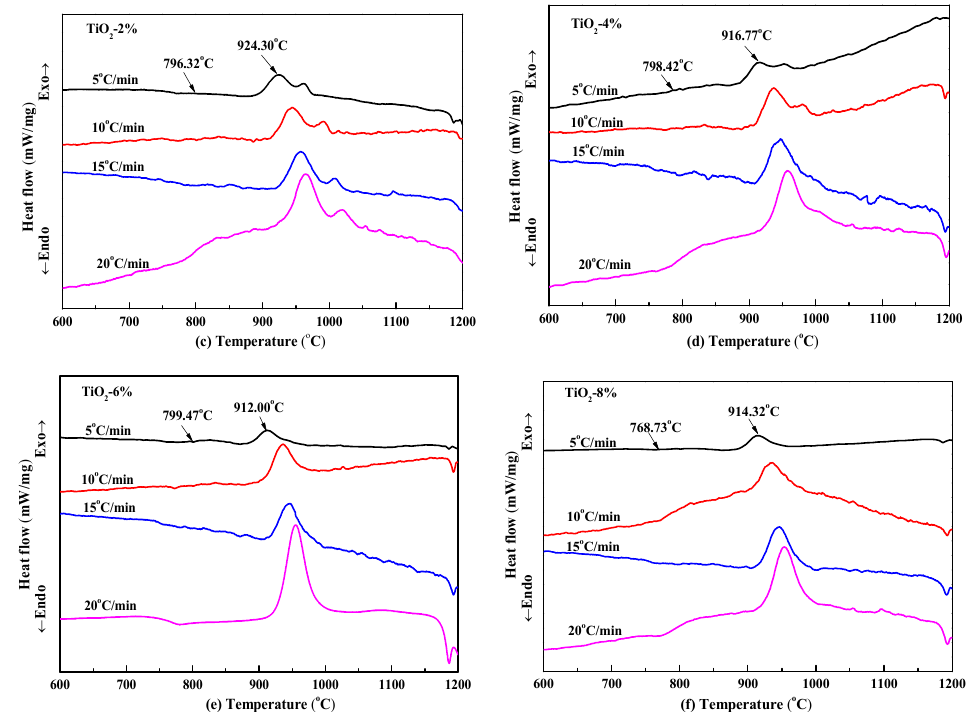
Figure 3. The di ff erential scanning calorimetry (DSC) curves of the samples with di ff erent contents of Figure 3. The differential scanning calorimetry (DSC) curves of the samples with different contents of TiO 2 . ( a ) S1; ( b ) S2; ( c ) S3; ( d ) S4; ( e ) S5 and ( f ) S6. TiO 2 . ( a ) S1; ( b ) S2; ( c ) S3; ( d ) S4; ( e ) S5 and ( f ) S6.